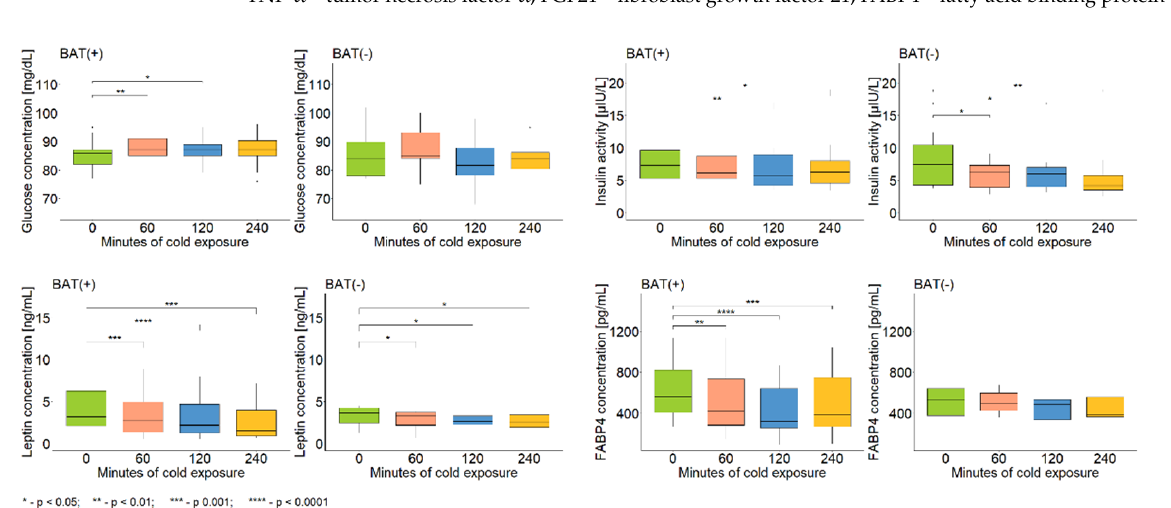
Figure 6. Differences in the level of glucose, insulin, leptin, and FABP4 during and after CE. The statistical differences were analyzed by Wilcoxon signed-rank test.